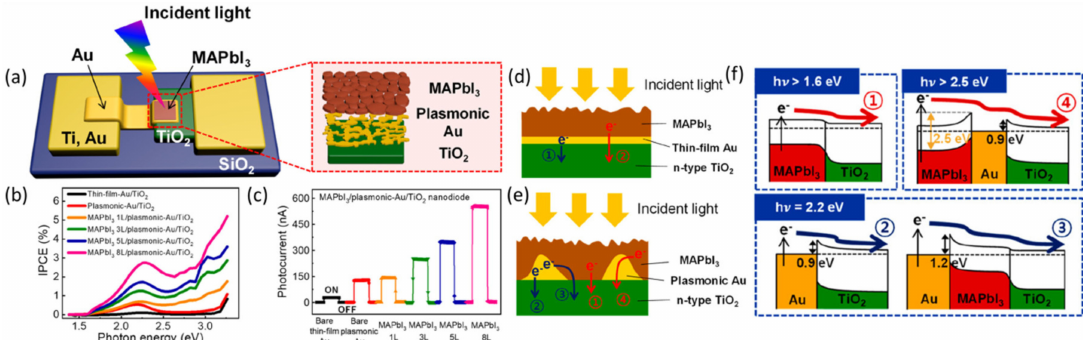
Figure 2. Generation of plasmonic hot electrons. ( a ) Schematic of the MAPbI 3 / plasmonic Au / TiO 2 nanodiode (left) and magnified illustration of the active area (right). ( b ) Incident photon-to-electron conversion e ffi ciency (IPCE) as a function of incident photon energy. ( c ) Short-circuit photocurrents measured on the MAPbI 3 / plasmonic Au / TiO 2 nanodiodes with respect to the number of MAPbI 3 layers. Schematic drawing of the hot-electron pathways for the MAPbI 3 / thin-film Au / TiO 2 ( d ) and the MAPbI 3 / plasmonic Au / TiO 2 ( e ) structure. ( f ) Theoretically drawn energy levels of the MAPbI 3 / plasmonic Au / TiO 2 structure. Reproduced with permission from [30]. Copyright American Chemical Society,